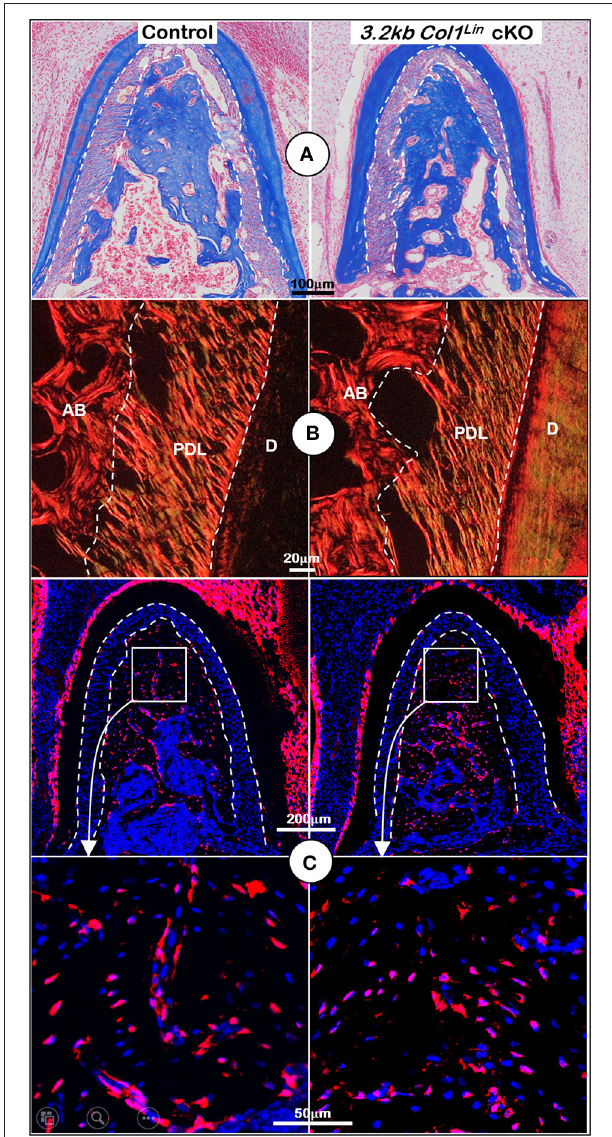
FIGURE 5 | Morphological analyses of mandibles from 3.2kb Col1 Lin Tgf β r2 conditional knockout (cKO) mice at the cellular level. (A) Masson’s trichrome staining showed no apparent change of alveolar bone mass in the cKO mice ( right ). (B) Polarized light images displayed a similar collagen fiber distribution of periodontal ligament (PDL) in the control and cKO group ( right ). (C) The 3.2kb Col1 Lin tracing images revealed largely similar red cell numbers in both the control and the cKO alveolar bone. AB, alveolar bone; PDL, periodontal ligament; D,